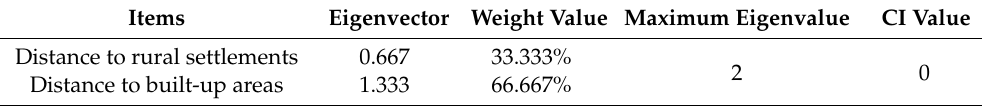
Table 11. AHP results for natural